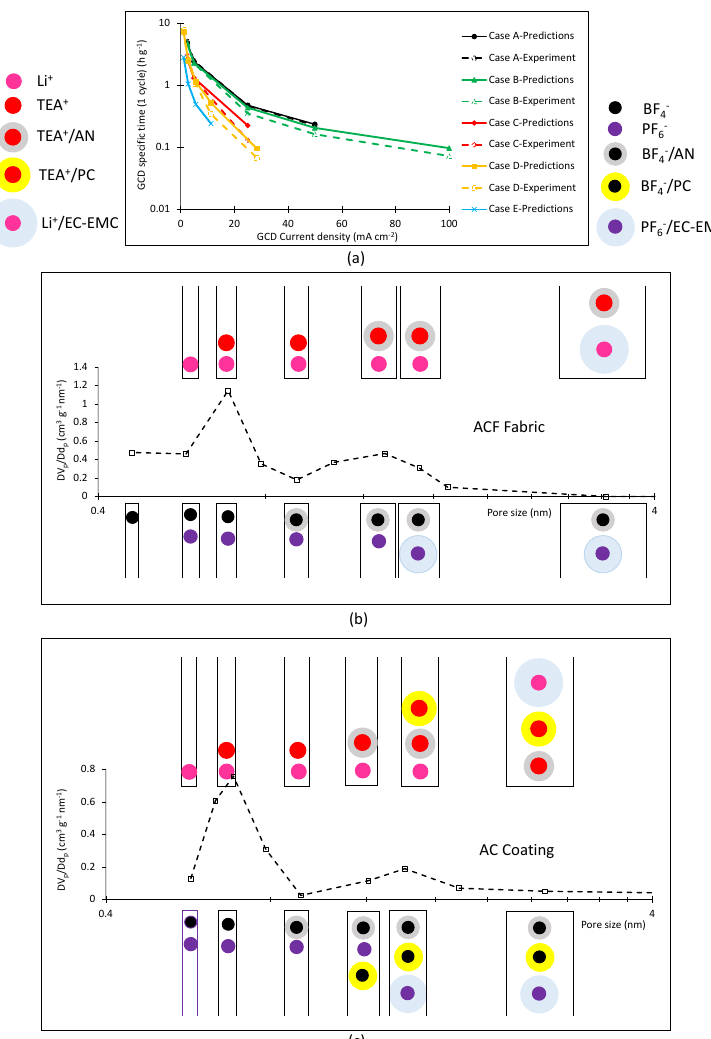
Figure 9. Predicted EDLC performance in ( a ), and relationship between the size of ion (solvated or desolvated) and pore size in ( b ) for ACF fabric and ( c ) for AC coating. Electrodes: ACF fabric in Cases A and E; AC coating in Cases B, C and D. Electrolyte: 1.5 M TEABF 4 /AN in Cases A and B; 1.5 M TEABF 4 /PC in Case C; 1 M LiPF 6 /EC-EMC in Cases D and E. Experimental data in ( a ) from studies [16,18,38,62].